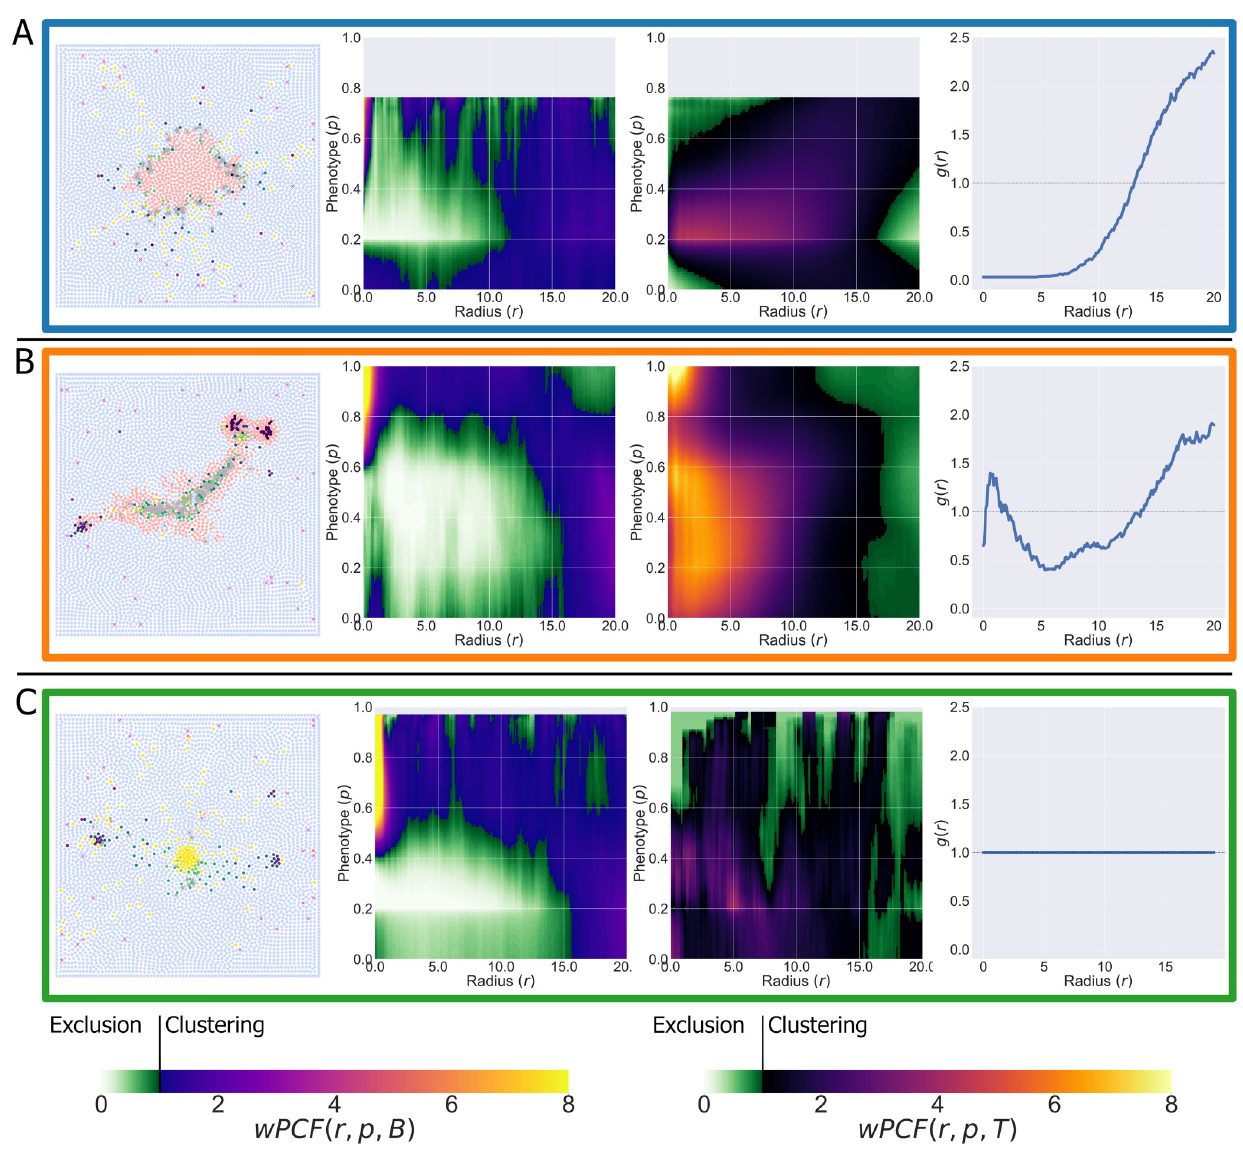
Fig 6. ‘PCF signatures’ for Equilibrium, Escape and Elimination. We consider parameter combinations representing Equilibrium (A, w m ¼ 1 ; c ¼ 0 : 8 ), Escape (B, w m ¼ 3 : 5 ; c ¼ 0 : 7 ) and Elimination (C, w m ¼ 1 : 5 ; c ¼ 0 : 3 ). For each, we show a representative simulation at t = 500. 1 = 2 1 = 2 1 = 2 c c c The wPCFs describing macrophage relationships with blood vessels and macrophage relationships with tumour cells are shown, alongside the cross-PCF describing blood vessel to tumour cell relationships (each averaged over 10 simulation